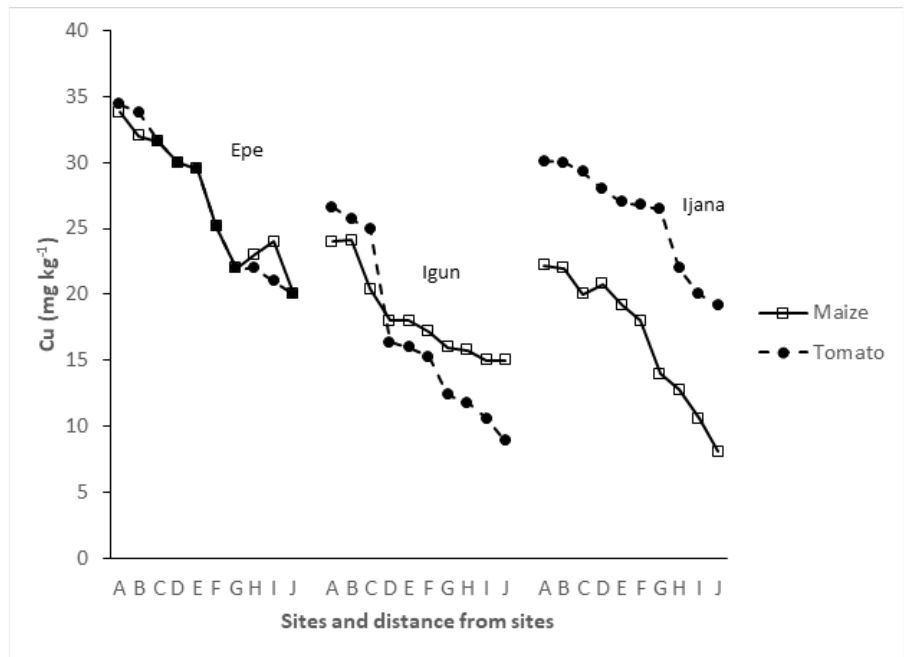
Figure 8: Concentrations of Cu in maize and tomato crops at Epe, Igun & Ijana (0 – 900 m) sites. A = 0 m from site; B = 100 m from site; C = 200 m from site; D = 300 m from site; E = 400 m from site; F = 500 m from site; G = 600 m from site; H = 700 m from site; I = 800 m from site; J = 900 m from site